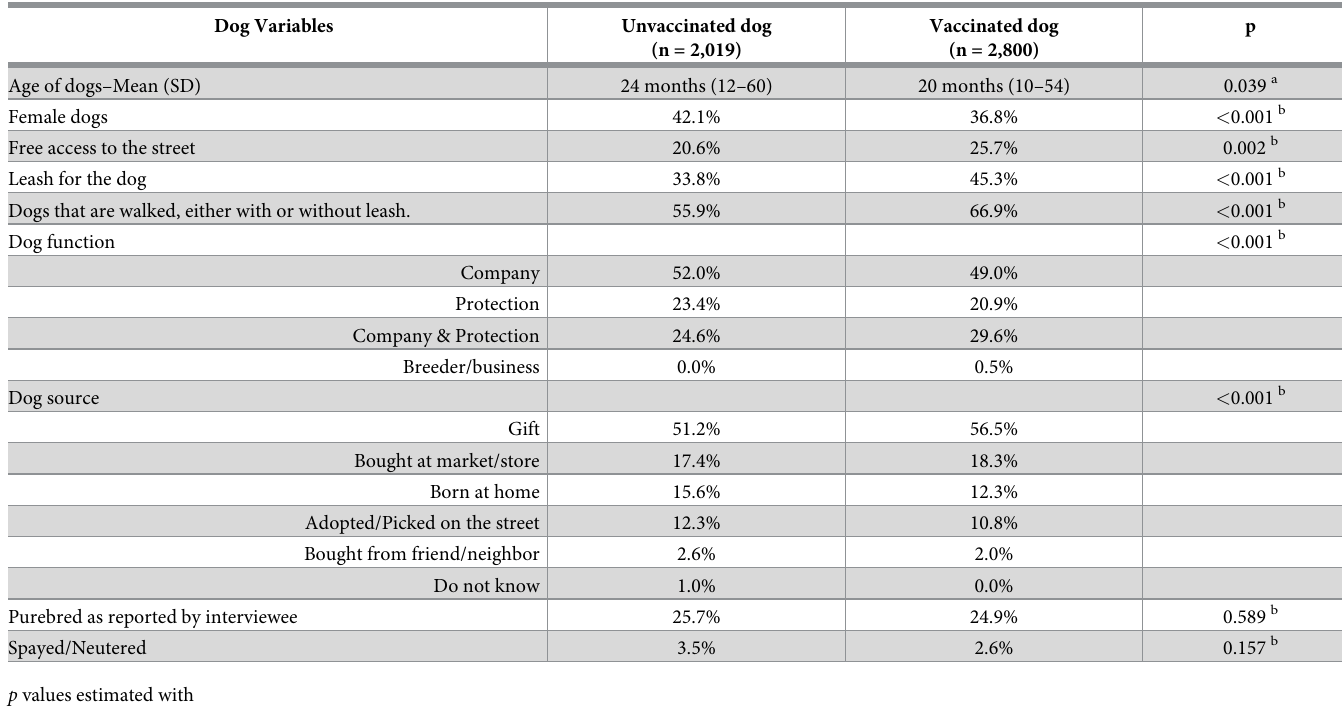
Table 2. Dog characteristics by vaccination status in the MDVC (dogs vaccinated privately not included). Dog Variables Age of dogs–Mean (SD)